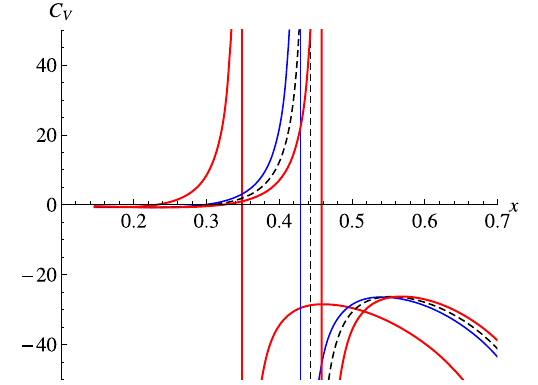
(black thin dashed line) 20